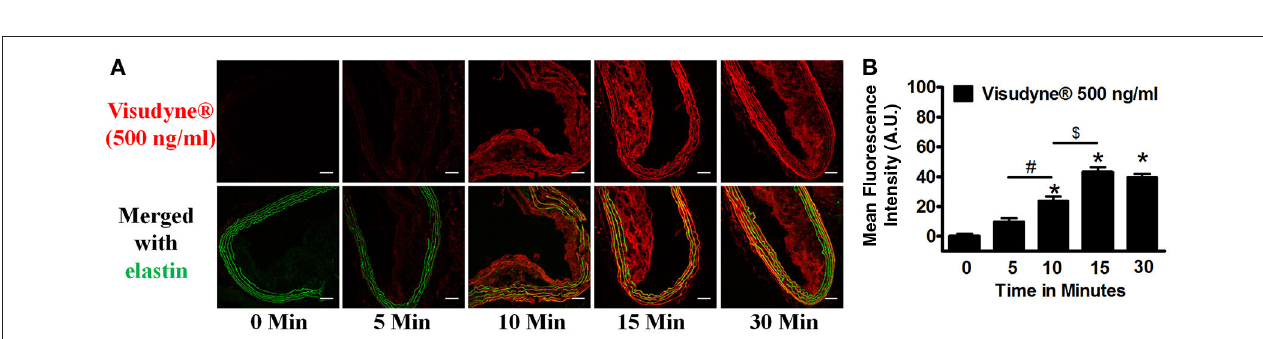
FIGURE 3 | Dose dependent Visudyne ® uptake. Excised aorta from ApoE − / − mice were perfused for 15min with 0 ( n = 6), 100 ( n = 3), 200 ( n = 3), or 500ng/ml ( n = 8) of Visudyne ® . (A) Arterial sections were excited with 405 nm light and fluorescence emission was measured between 650 and 750 nm. Upper panel illustrates characteristic fluorescence of Visudyne ® in red and lower panel is merged image with auto-fluorescence of elastin. Scale bar: 50 µ m. (B) Bar graph representing the Mean fluorescence intensity in each group. * P < 0.001 vs. 100 ng/ml, # p < 0.001 100ng/ml vs. 200ng/ml, $ p < 0.001 200ng/ml vs. 500ng/ml.